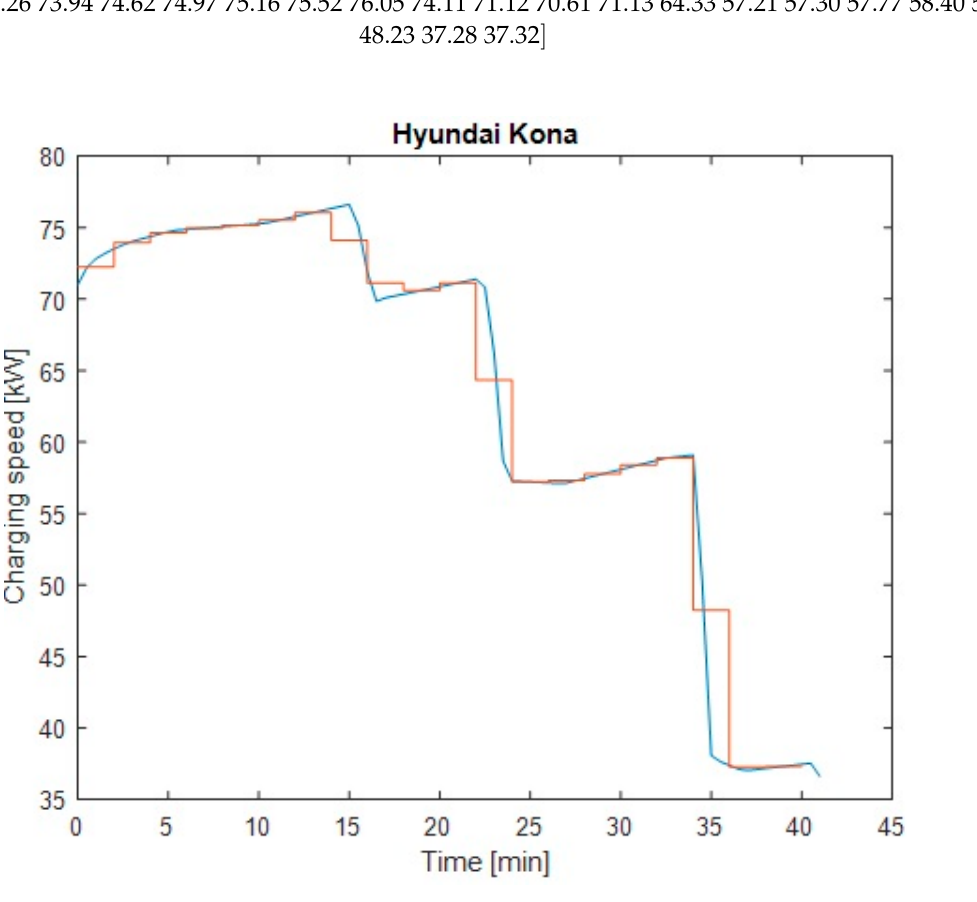
Figure 5. Continuous (in blue) and discretized (in orange) charging profile of Hyundai Kona. A list of the different EVs model considered in the optimization process is created.